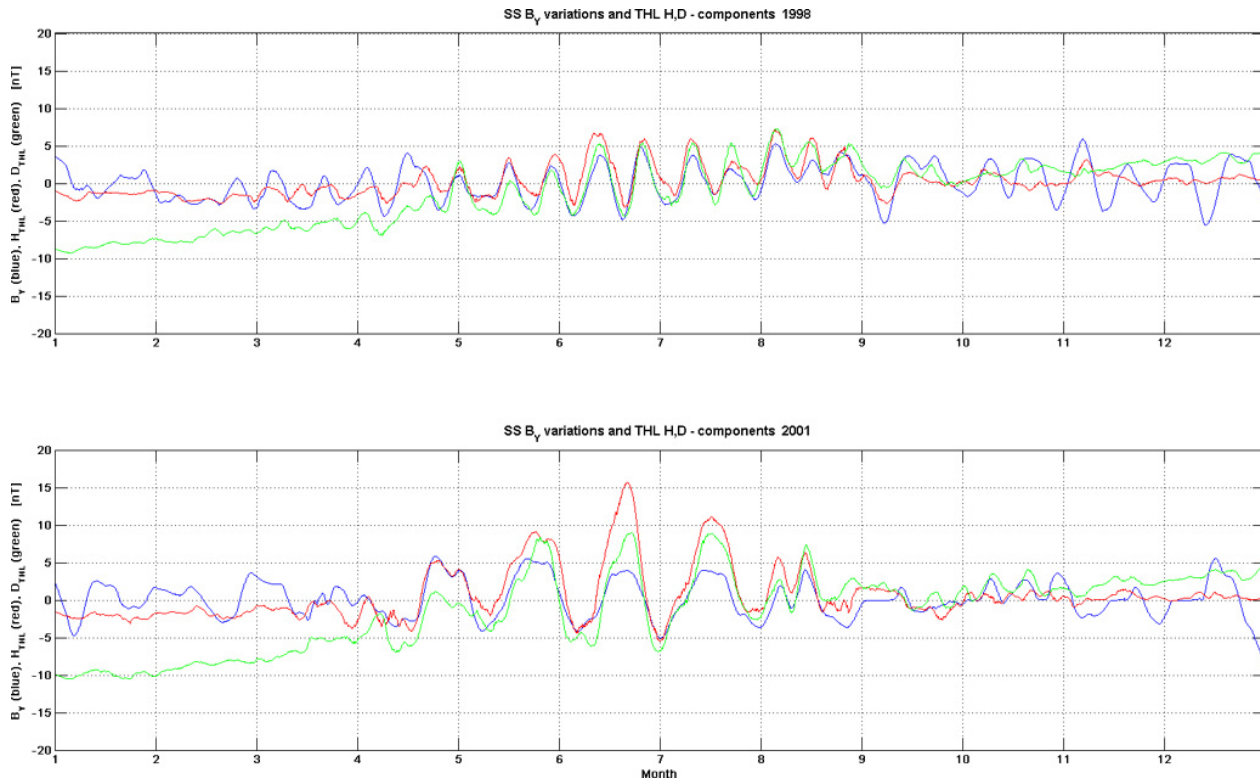
Fig. 4. Results of comparison between SS structures displayed in the IMF B y variations (blue) measured by spacecraft and ground magnetic variations observed in H (red line) and D (green line) components at Thule for 1998 and 2001, where the mean values of all quantities were reduced to zero and the amplitudes were